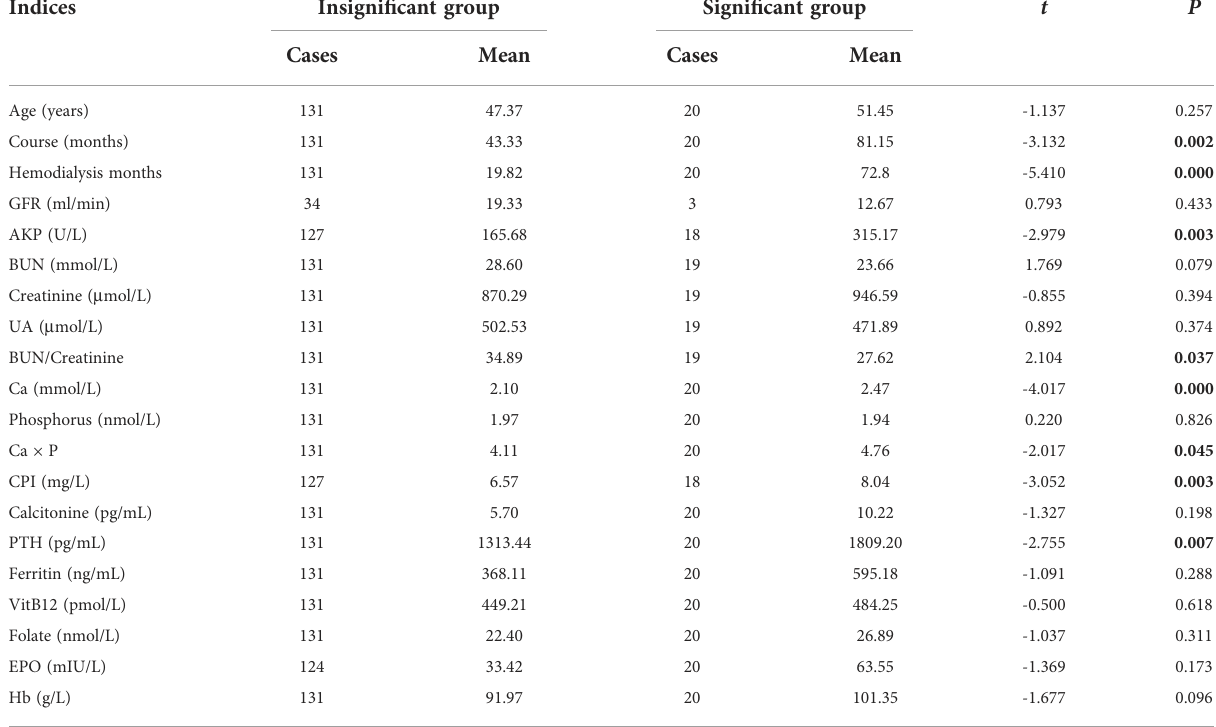
TABLE 6 The comparison of some indices between insigni fi cant and signi fi cant MIBI uptake groups during delayed phase. Indices Insigni fi cant